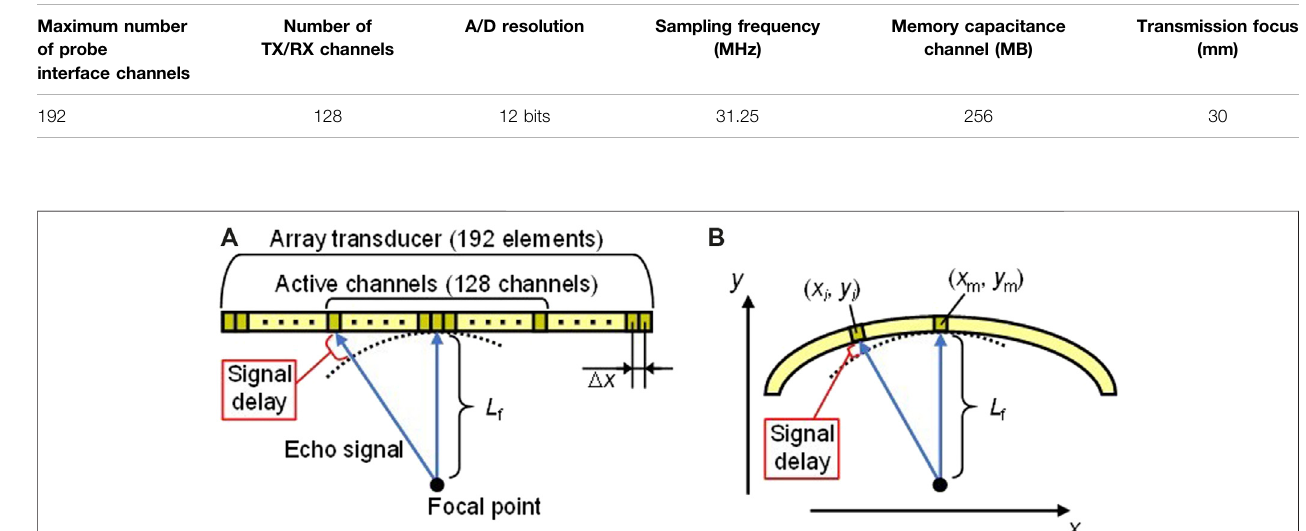
TABLE 2 | Speci fi cations of ultrasonic imaging equipment.